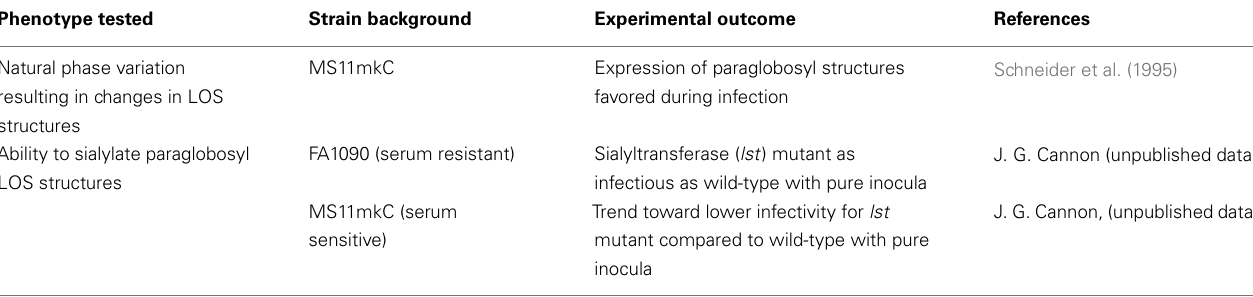
Table 2 | Effects of lipoologosaccharide (LOS) features on experimental